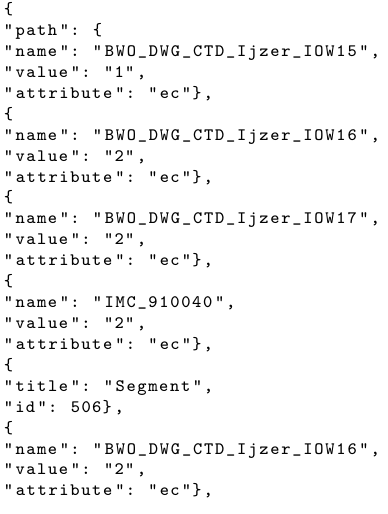
Figure 24. Flow Paths for Query